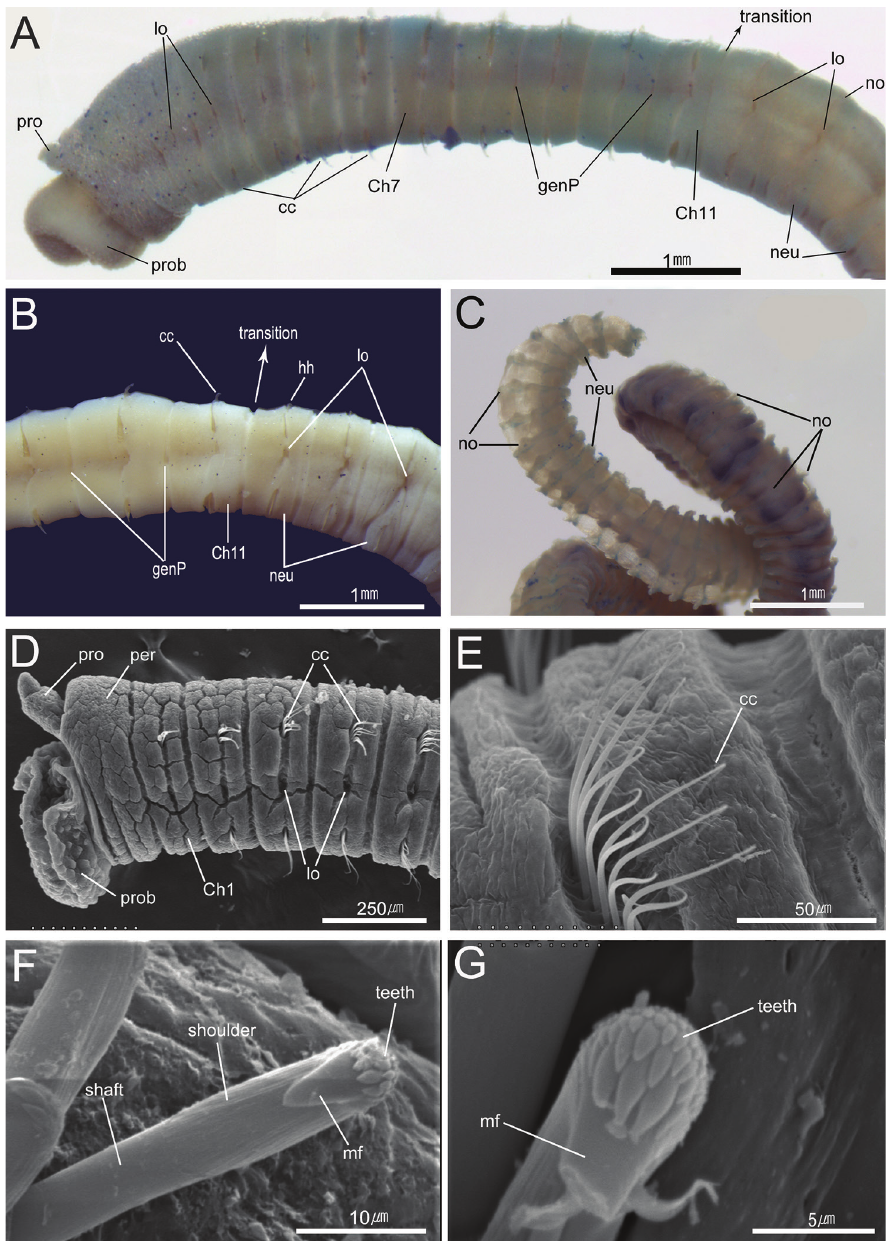
Figure 3. Notomastus koreanus sp. n. A−C photomicrographs A anterior end in left lateral view (show- ing methyl green staining reaction, MABIKNA00066311) B chaetigers 9–15 in left lateral view (MABIK- NA00066396) C posterior end (MABIKNA00066396) D–G scanning electron micrographs (using addi- tional specimens from type locality) D anterior 6 thoracic segments in left lateral view E capillary chaetae of chaetiger 4 F–G abdominal hooded hooks in frontal view. Abbreviations: cc, capillary chaetae; Ch, chaetiger; genP, genital pore; hh, hooded hooks; lo, lateral organ; mf, main fang; neu, neuropodium; no, notopodium; per, peristomium; pro, prostomium; prob, proboscis; transition, transition between thorax and